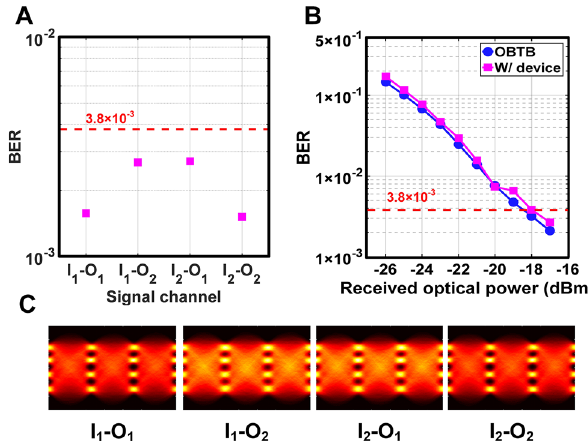
Figure 10: Experimental results for the high data rate switching of the device. (A) Bit error ratio (BERs) of four switching configurations. (B) BER versus received optical power. (C) Eye diagrams for the four switching configurations of the